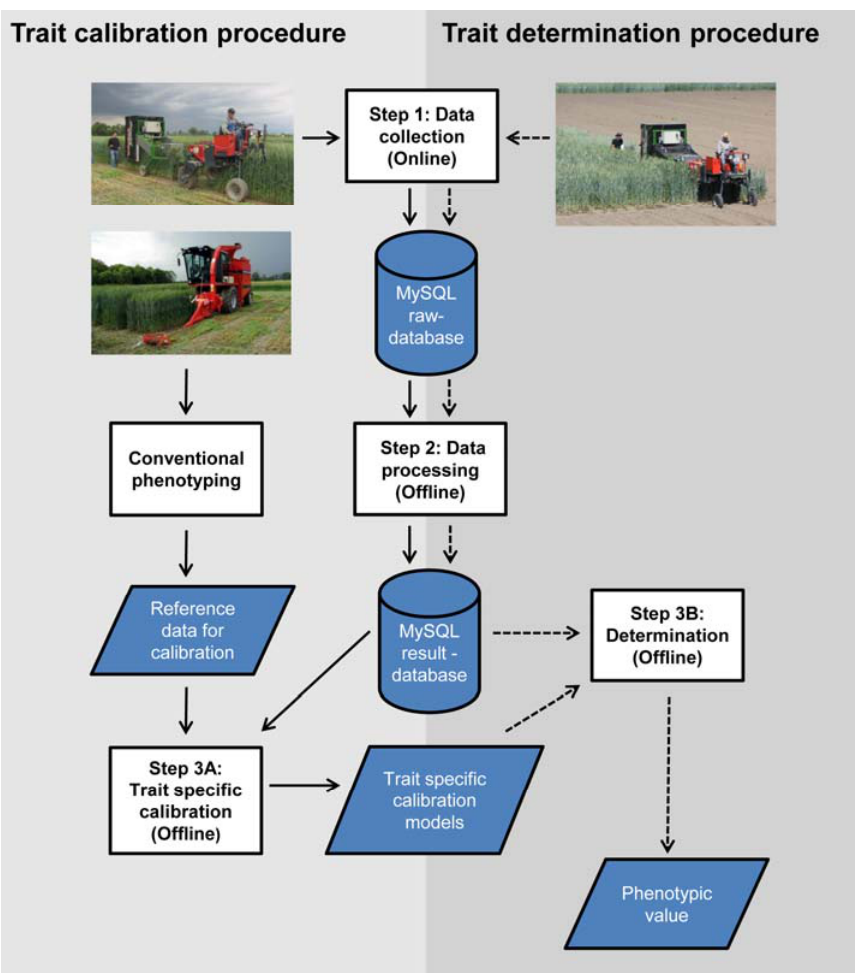
Figure 4. Trait calibration and trait determination procedure, each incorporating the three steps of the developed phenotyping process: Data collection on the field (step 1), data